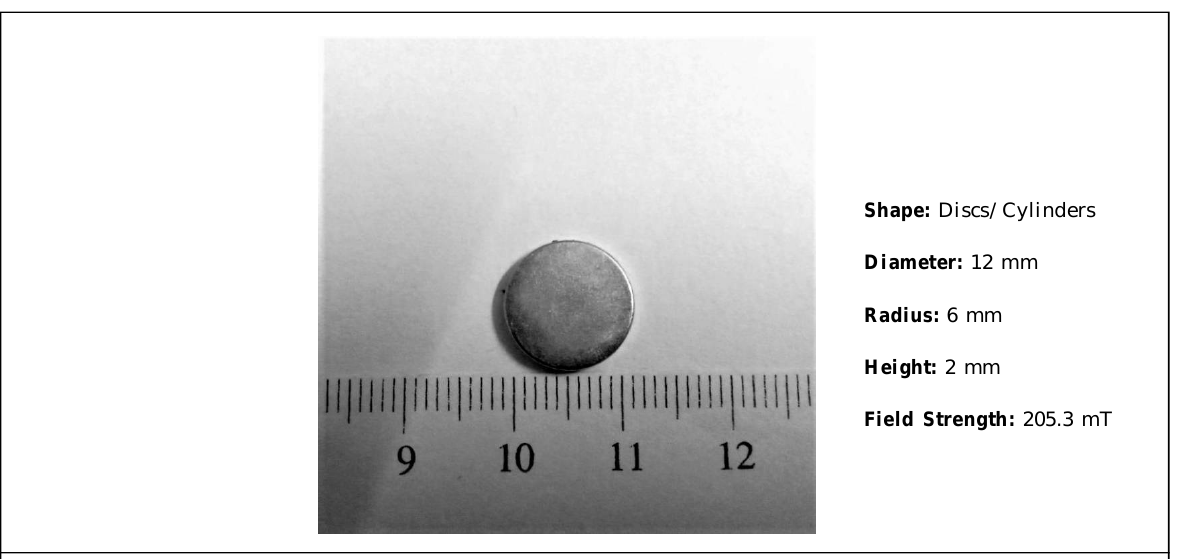
Figure 1: Neodymium magnet used in the experiment